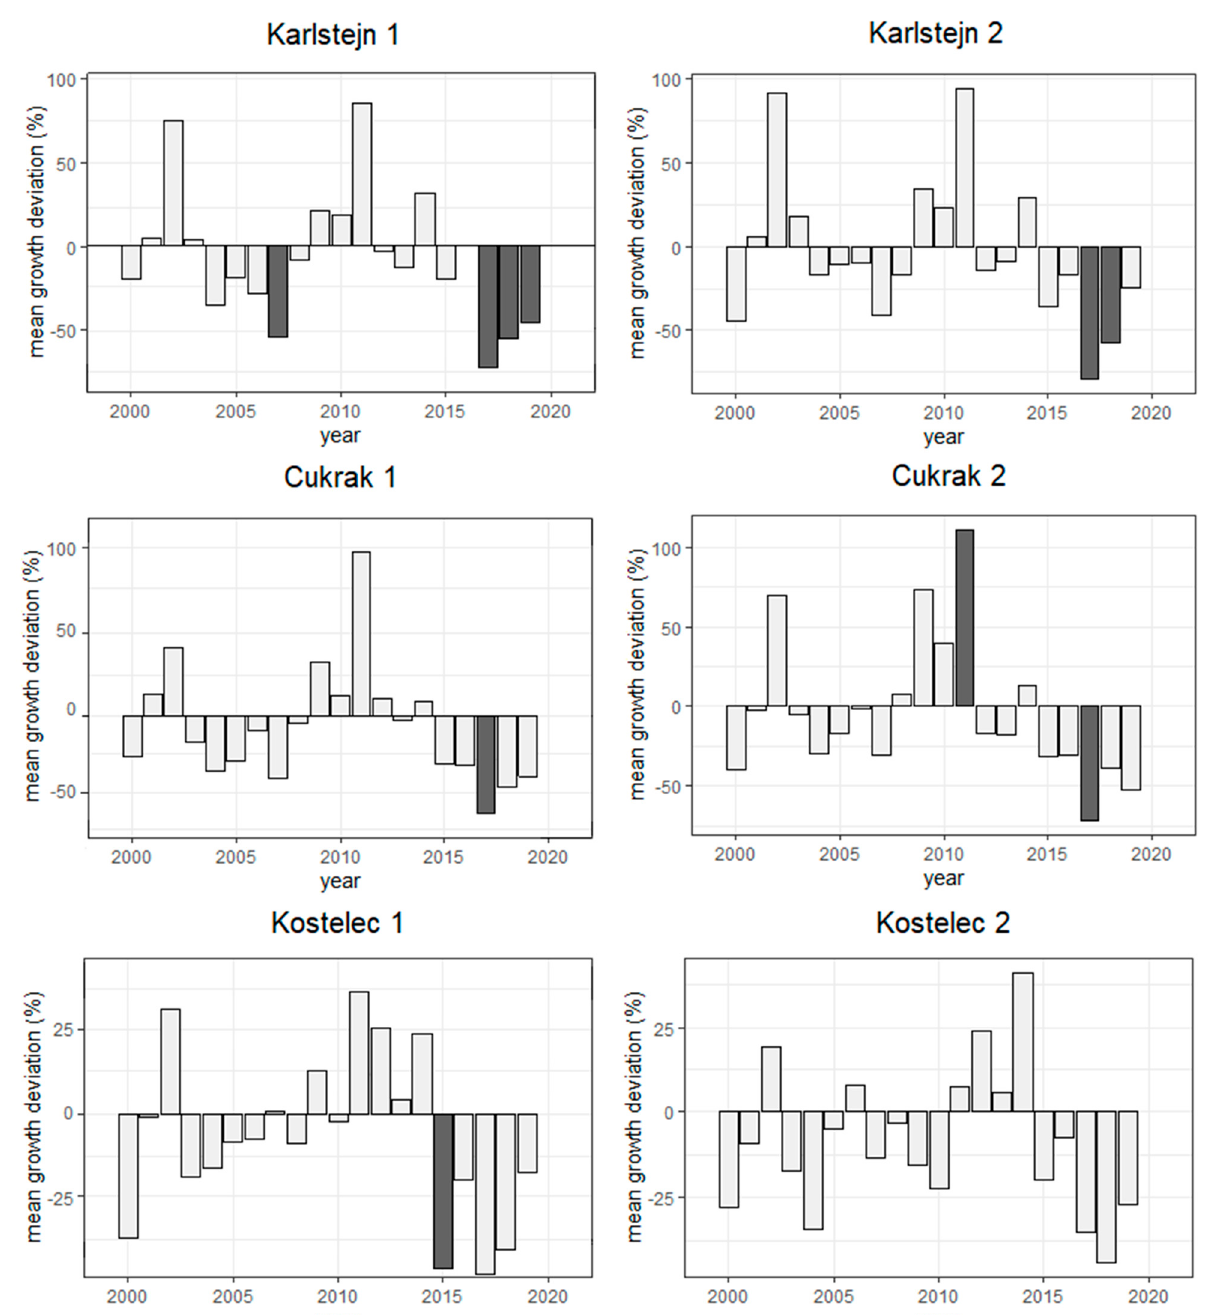
Figure 5. Pointer years (relative growth change) for Norway spruce (2000–2018); dark grey bars—pointer years; light grey bars—mean growth deviation.